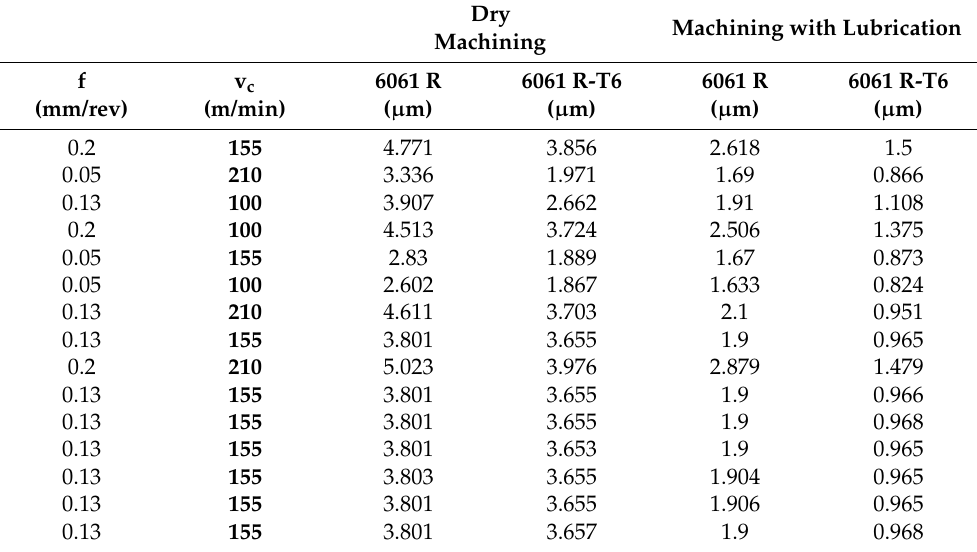
Table 4. Average surface roughness values as a function of feed and cutting speed.